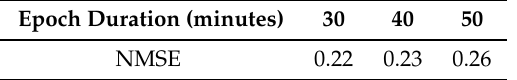
Table 2. Field estimation performance of Scheme 2 with different values of the epoch